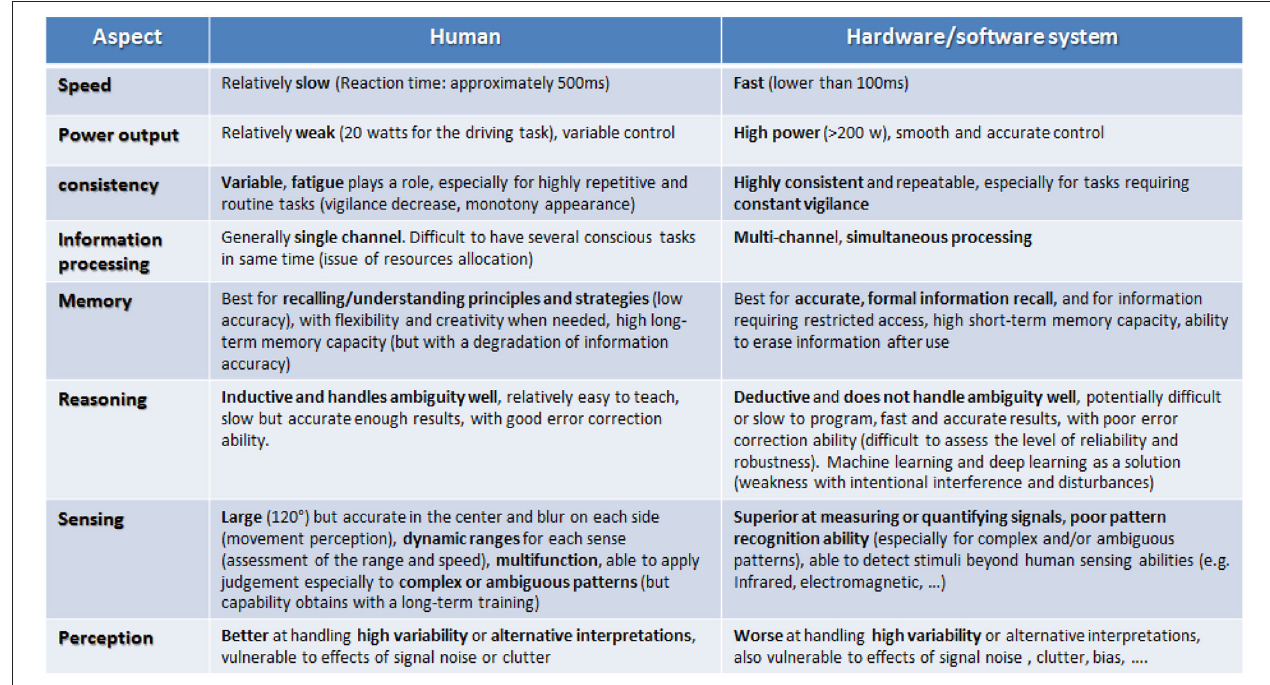
FIGURE 5 | Fitts list of strengths and weaknesses of both Human and embedded system (sensors/computer/processing) across various criteria according to ITF/OECD (2018), Schoettle (2017), Cummings (2014), and de Winter and Dodou (2014).